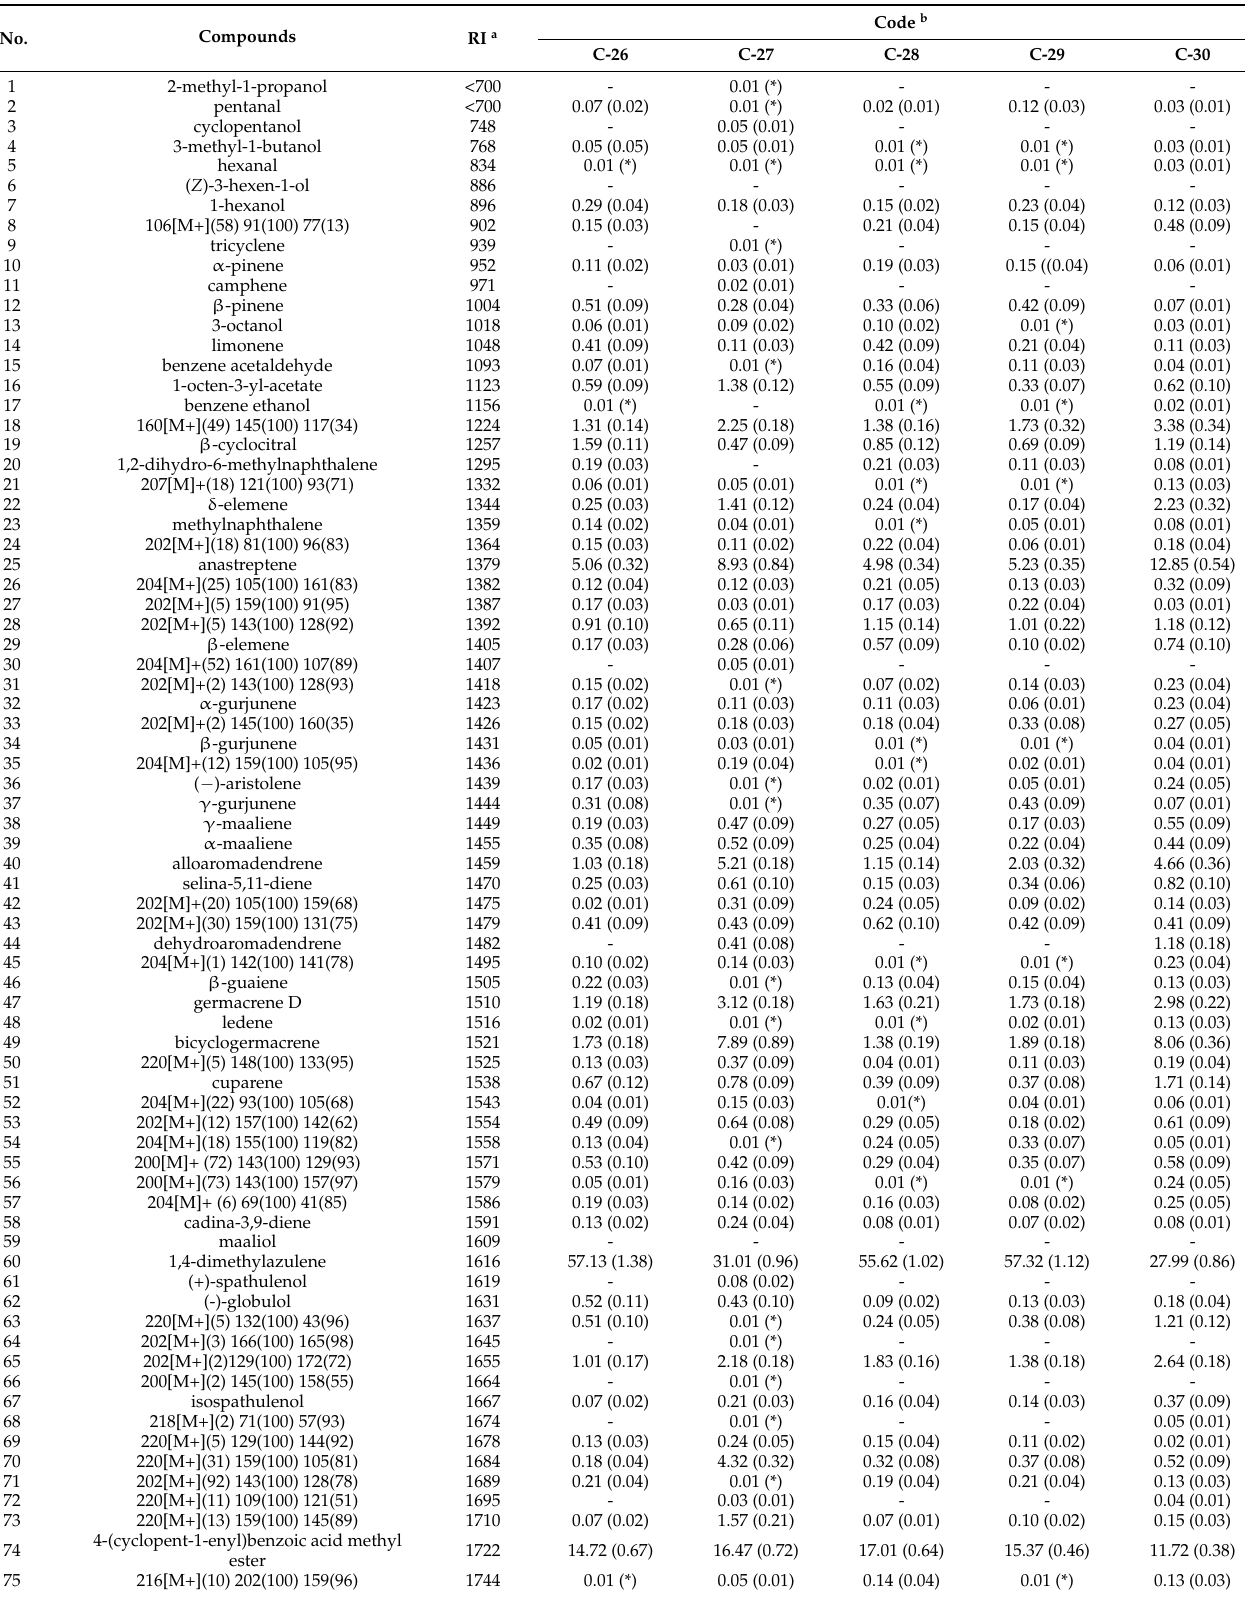
Table 7. Volatile compounds detected in the samples